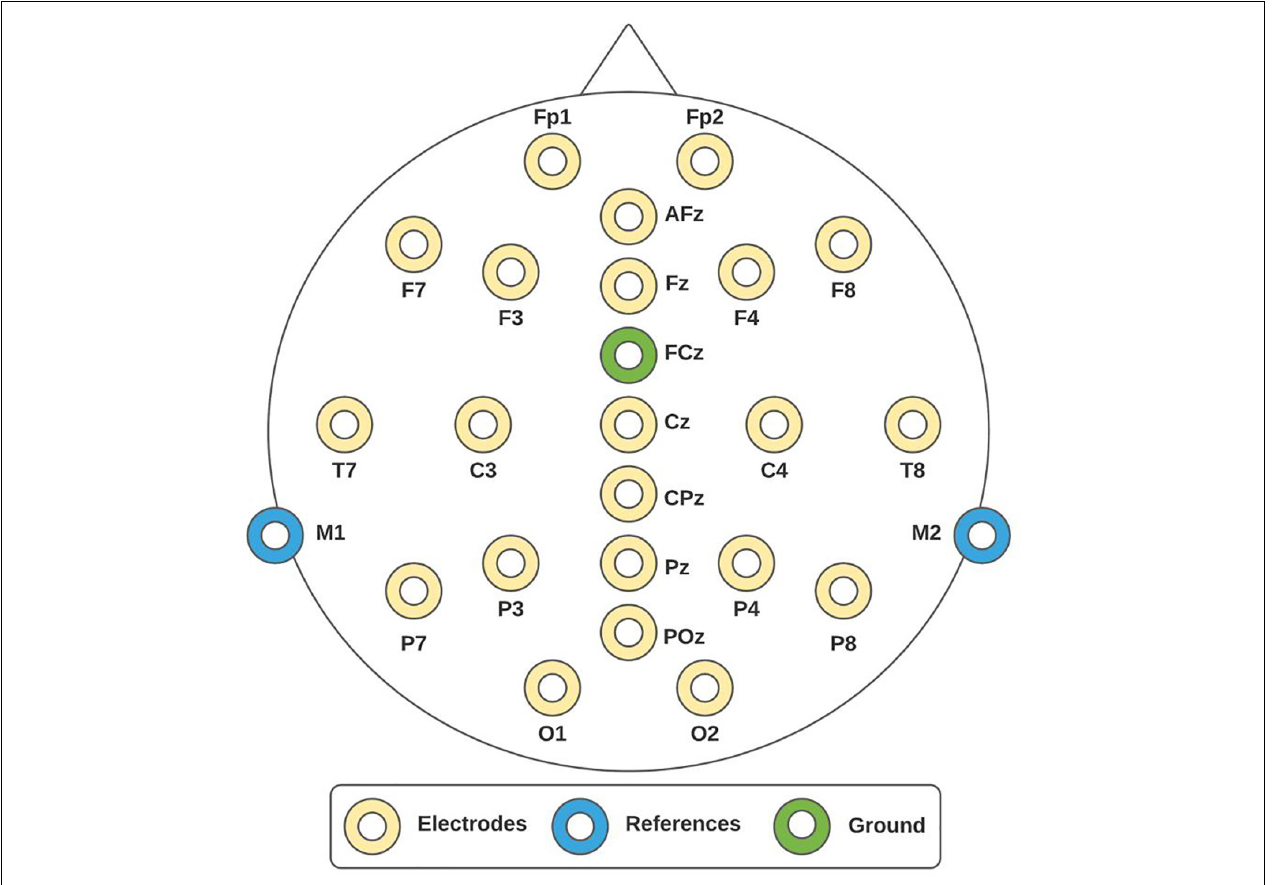
FIGURE 1 | 10/20 system. Electroencephalographic (EEG) montage consisted of 24 channels, whereby 22 of them were recording sites (yellow electrodes), one reference (blue electrodes), and one ground (green